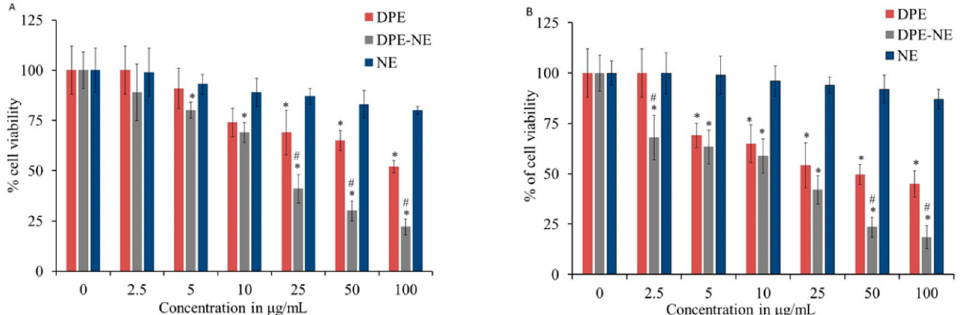
Figure 10. Cell viability evaluation of free DPE, optimized PEGylated DPE, and blank NE against ( A ) MCF-7 and ( B ) HepG2 cell lines following 48 h incubation. Results are stated as the mean ± S.D * Statistically significant with blank NE ( p < 0.05). # Statistically significant with free drug (DPE) ( p < 0.05).